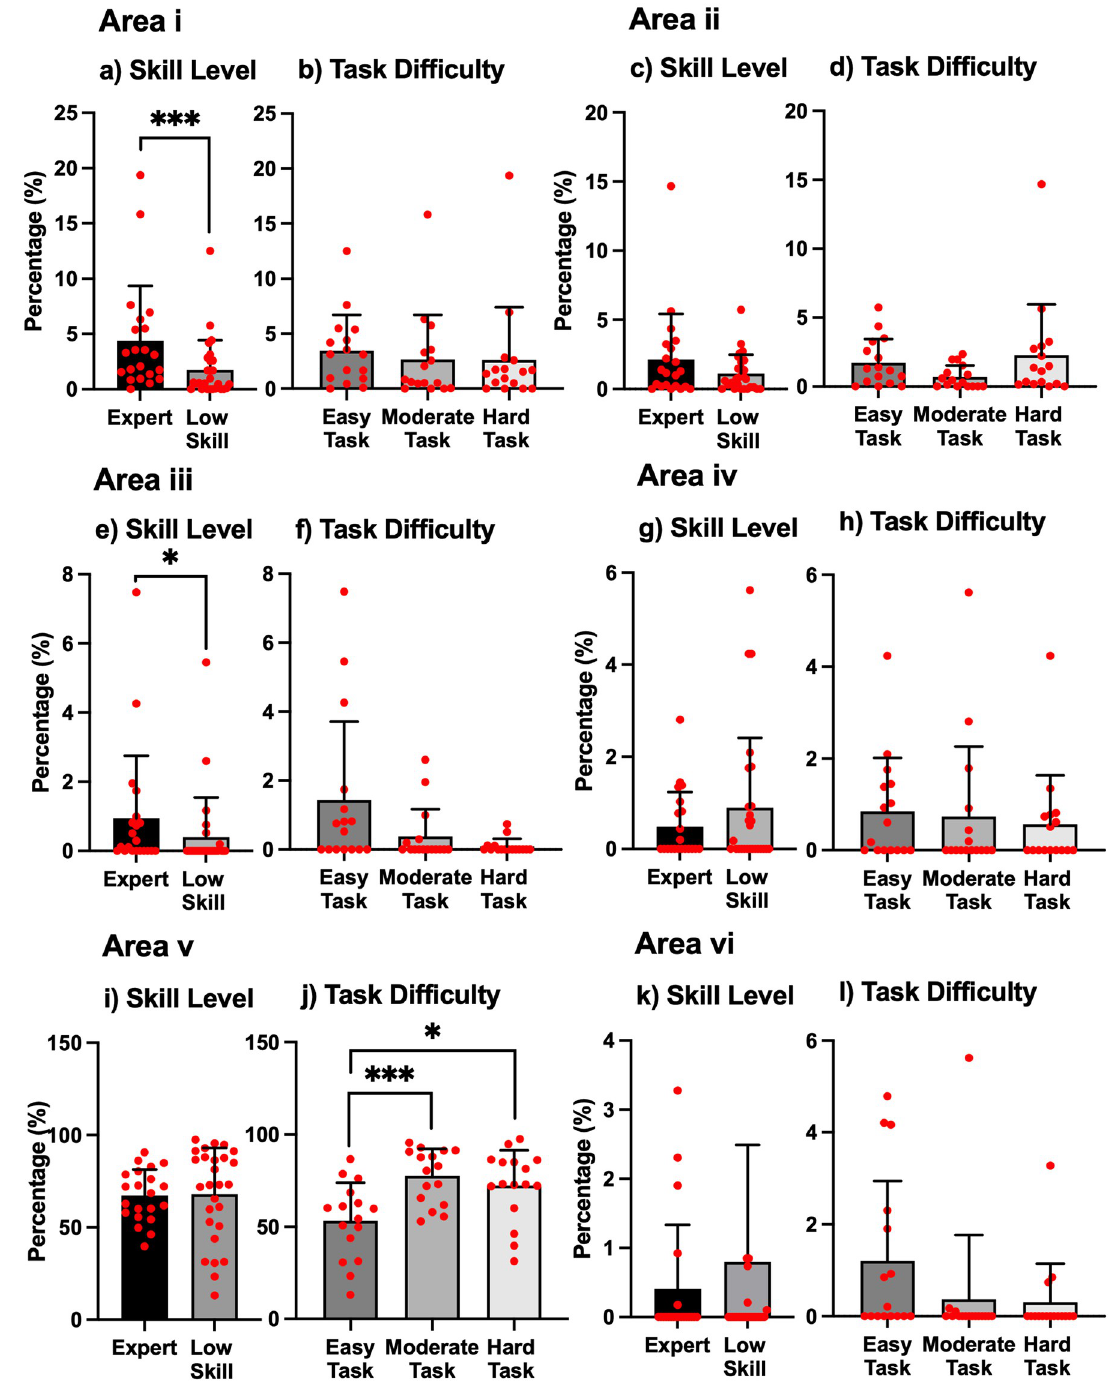
Fig 6. Ratio of gaze distribution in six areas. Each red circle represents an individual data point. a: Significance level was set at ��� p < .001, e: Significance level was set at � p < .05, j: Significance level was set at � p < .017 and ��� p < .001.